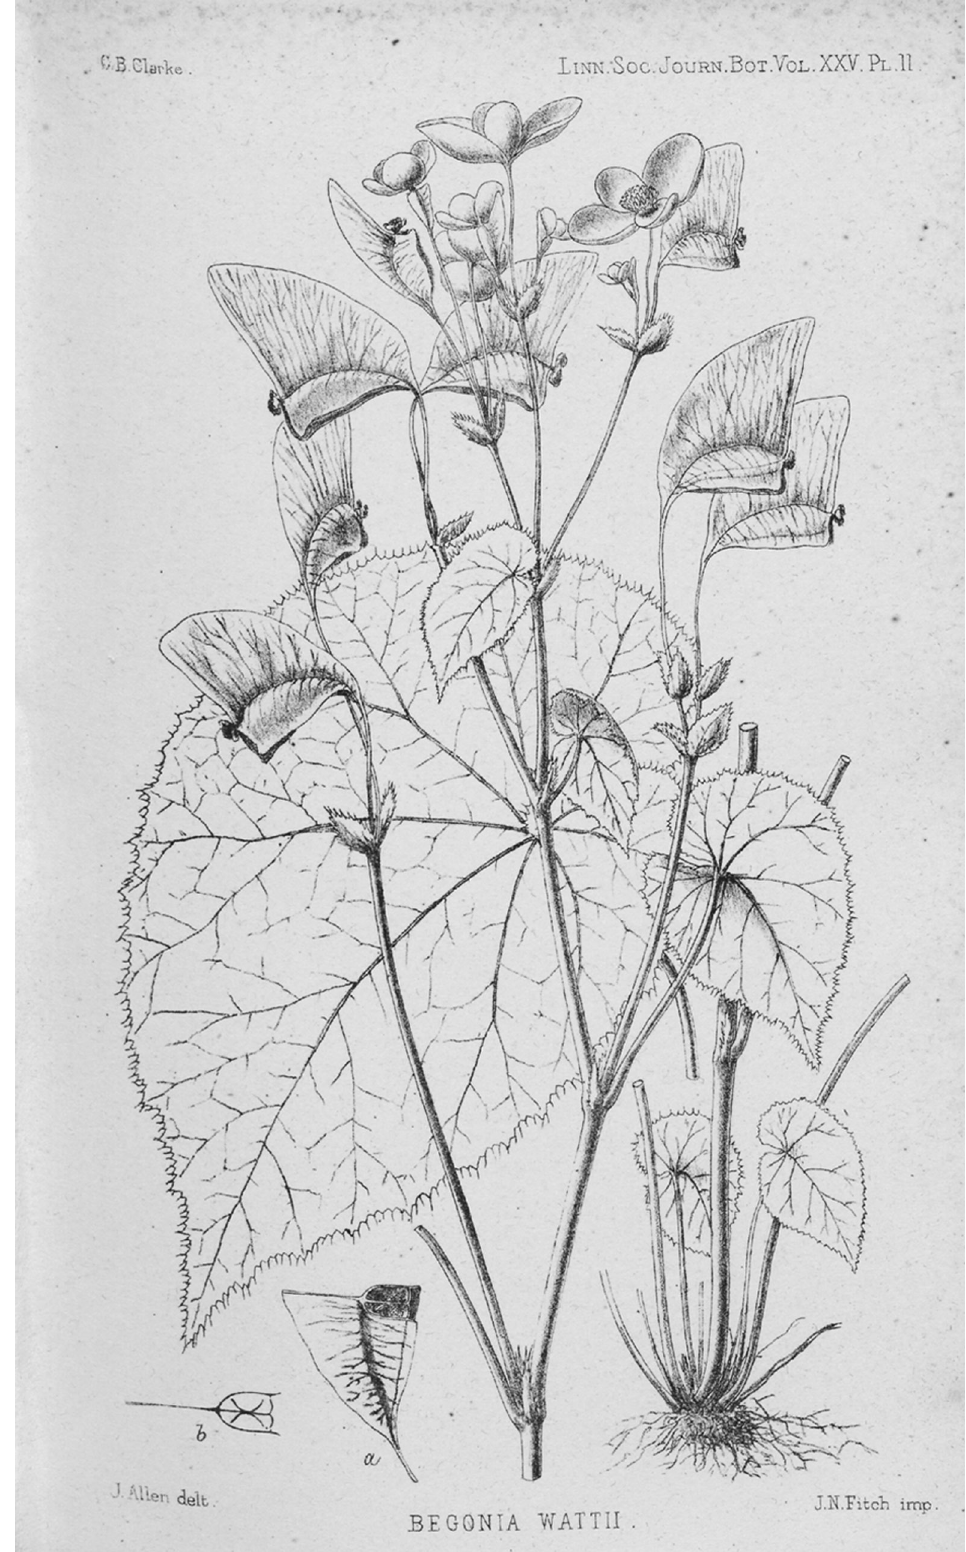
Fig. 62. Illustration of B. watti C.B.Clarke by J. Allen (Clarke 1890). a. Fruit dissection. b. Diagram of fruit cross-section. Image courtesy of RBGE library and Lynsey